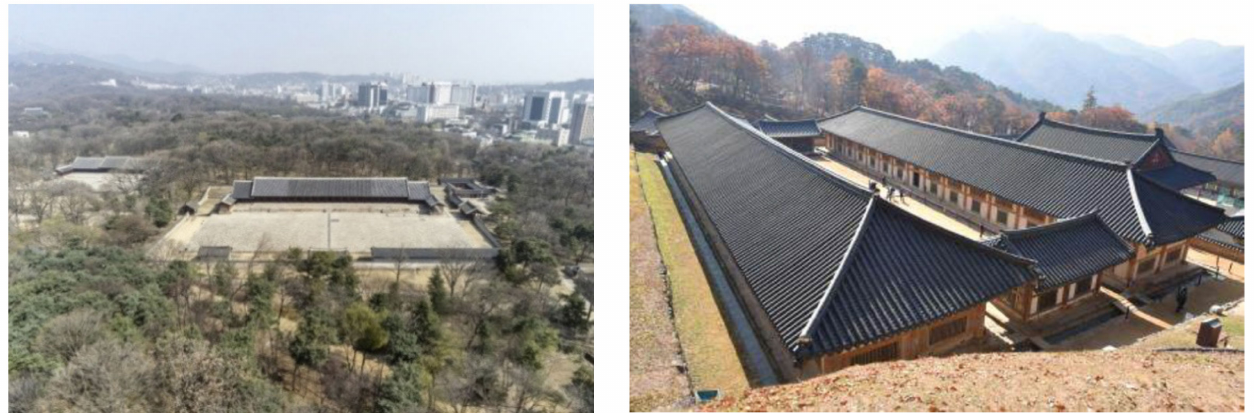
Figure 1. Wooden architectural heritage buildings in Korea. ( Left ) Jongmyo Royal Shrine (National Treasure of Korea, UNESCO world Heritage). ( Right ) Janggyeong Panjeon depository of the Tripitaka Koreana (National Treasure of Korea, UNESCO world